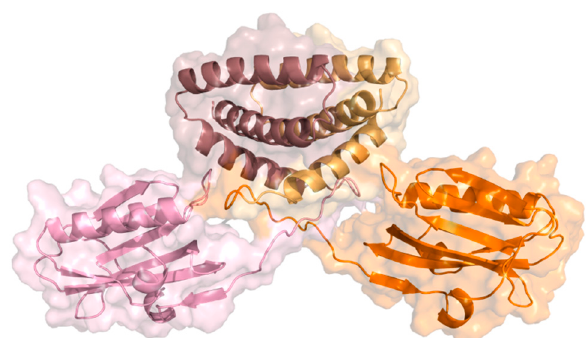
Figure 2. Ribbon and surface representations of the NS1 dimer highlighting its structural domains. Subunits 1 and 2 are represented in pink and orange, respectively; N-terminal RNA-binding domains (RBDs) are represented in dark pink and light orange (top) and effector domains (EDs) in light pink and bright orange (bottom) (PDB ID: 4OPH) [40].